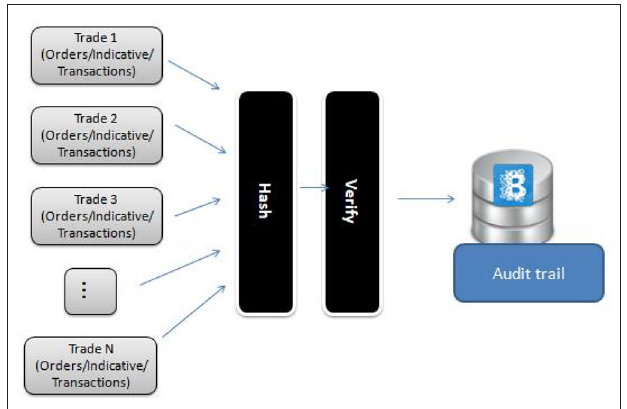
FIGURE 5 | System